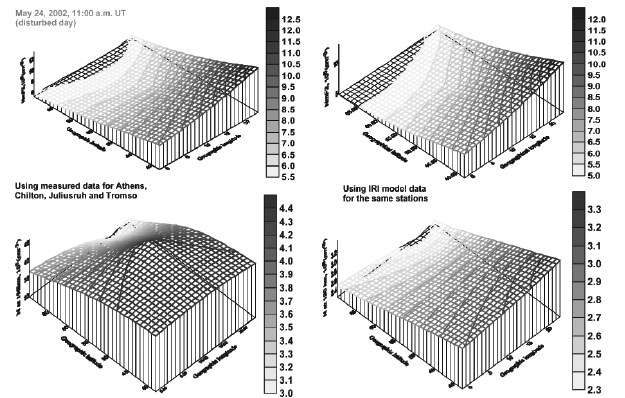
Fig. 3.10a. Plots of hmF 2 and electron density and 190 km across the European area, produced by combinations of the IRI-2000 model and observations. The top pair of graphs shows NmF 2 and the bottom pair show the 190 km electron density derived from values at Athens, Chilton, Juliusruh and Tromsø; the left-hand pair uses observed da- ta and the right-hand pair uses IRI-2000 data for the same four locations.